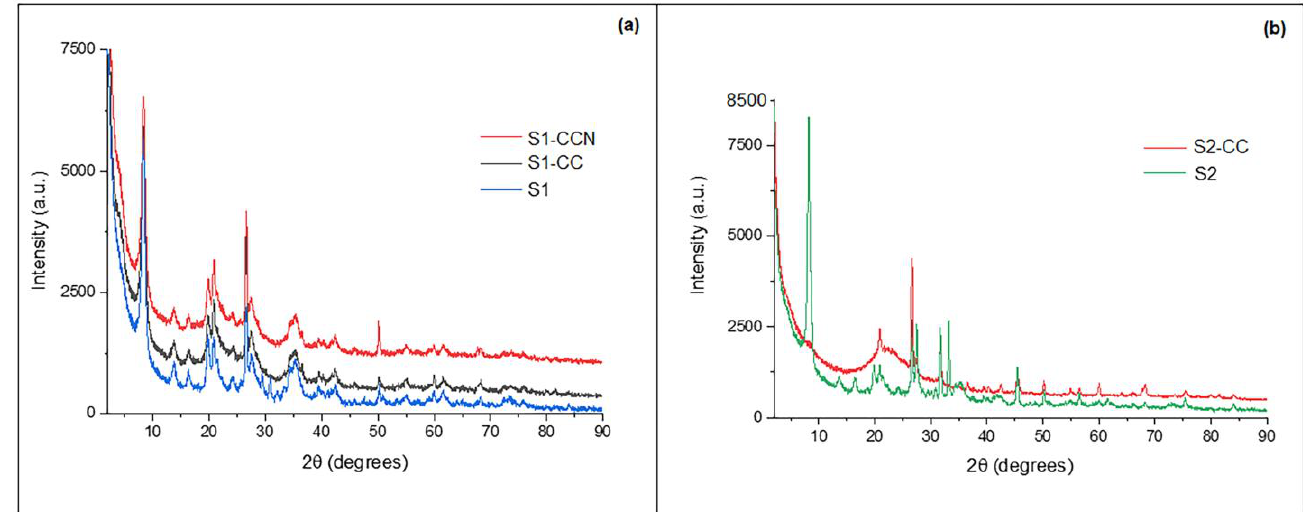
Figure 4. XRD patterns of the hybrid materials modified with aminopropyl groups ( a ) and glycine residue ( b ).